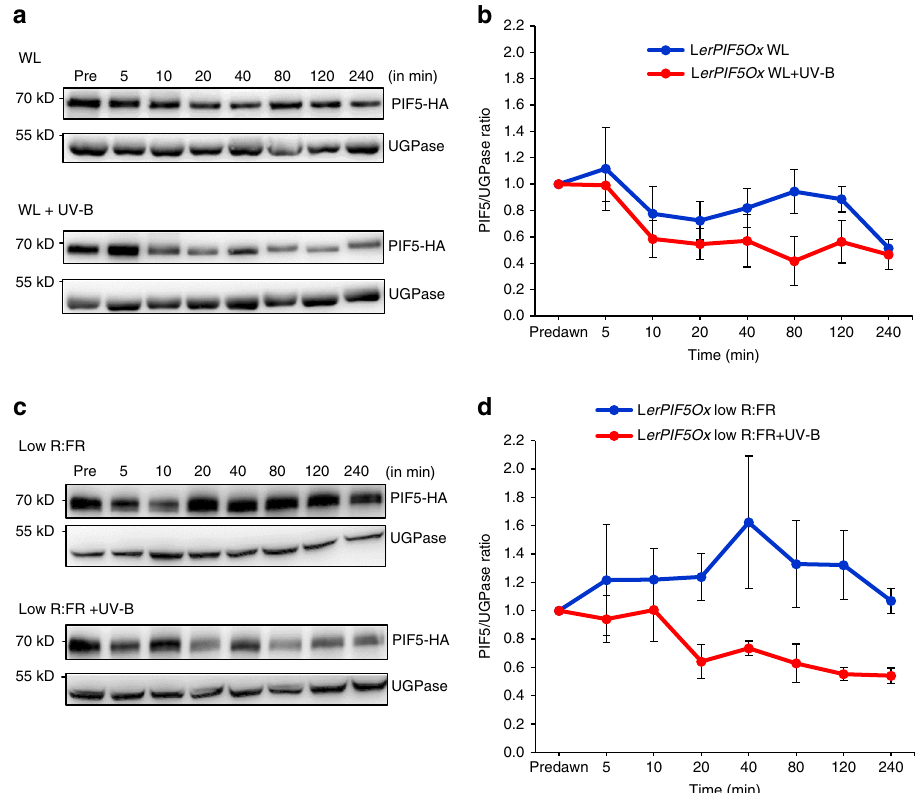
Fig. 2 UV-B rapidly decreases PIF5 protein abundance in high and low R:FR. a Western blots of PIF5-HA and UGP ase in L erPIF5Ox seedlings grown for 10 days in 16 h light/ 8 h dark cycles before transfer at dawn to high R:FR ± UV-B. b Quanti fi cation of PIF5 protein in three independent biological repeats. c Western blots of PIF5-HA and UGP ase in L erPIF5Ox seedlings grown for 10 days in 16 h light/8 h dark cycles before transfer at dawn to low R:FR ± UV-B. d Quanti fi cation of PIF5 protein in three independent biological repeats. Bars represent s.e.m. Source data are provided as a source data fi le